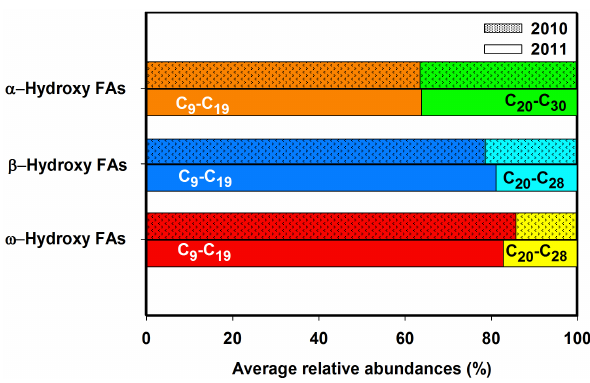
Figure 3. Bar graph, showing the relative abundances of low molec- ular weight (C 9 –C 19 ) and high molecular weight fatty acids (C 20 – C 30 for α -hydroxy; C 20 –C 28 for β - and ω -hydroxy) in their total mass for the snow samples collected during the winter of 2010 and 2011. The upper and lower horizontal bars for each type of hydroxy fatty acid indicate the data for 2010 and 2011, respectively.